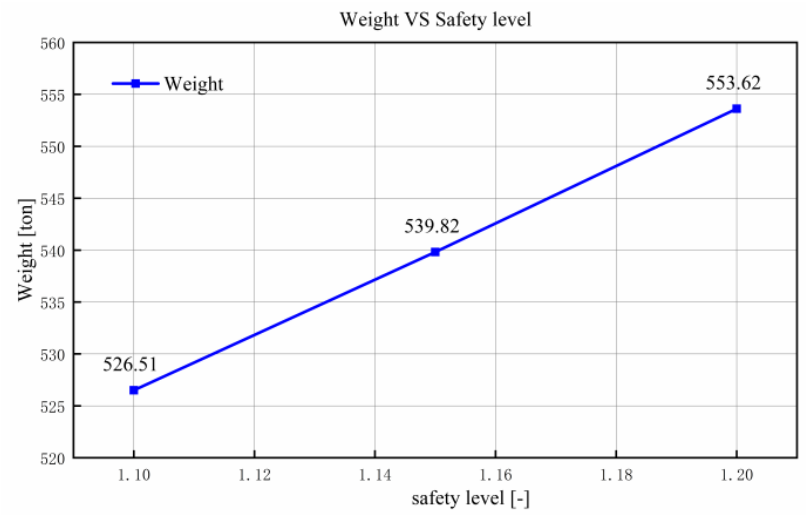
Figure 9. Tower segment weight VS. safety level.